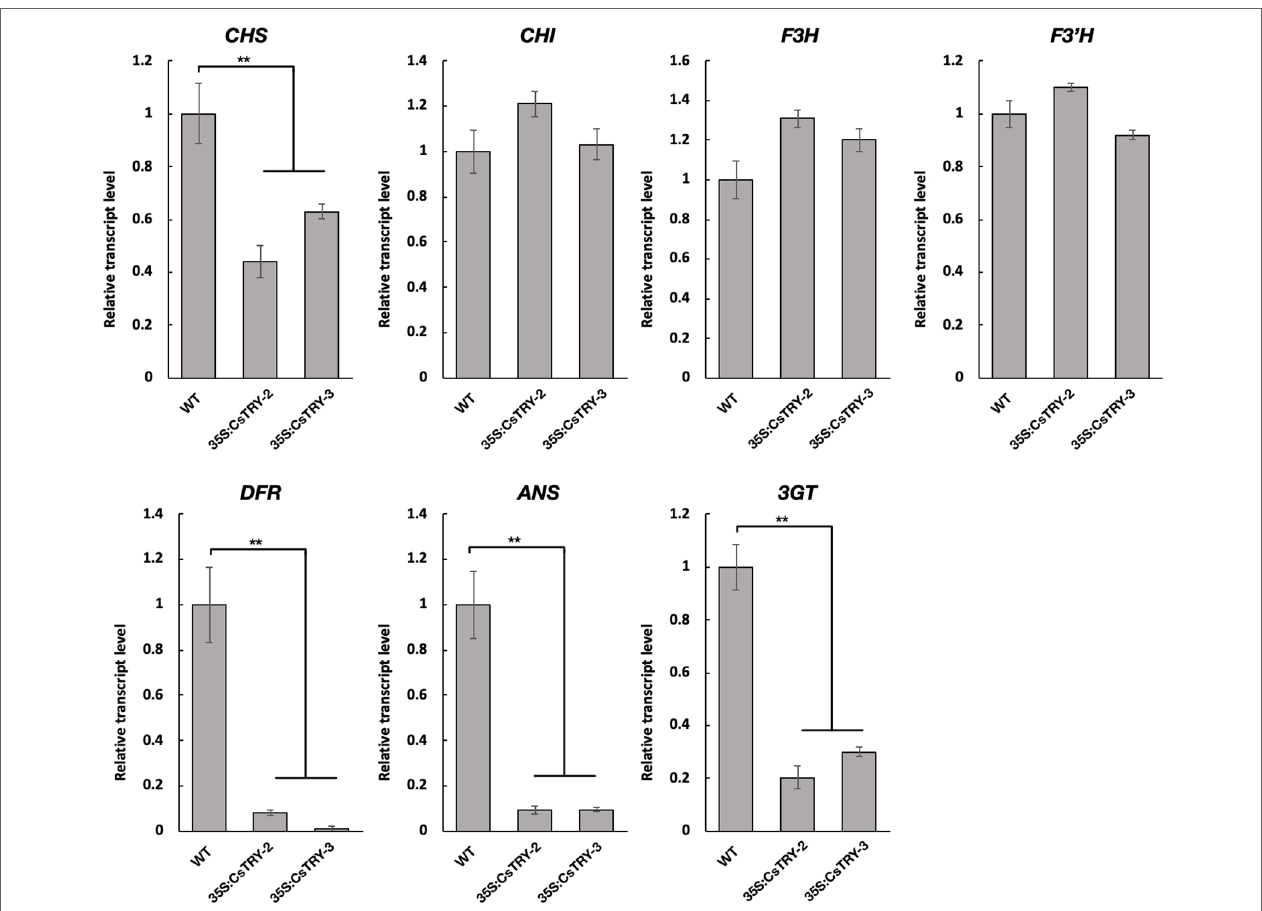
FIgURE 3 | Relative transcript levels of flavonoid structural genes in the petals of tobacco lines 35S:CsTRY (35S:CsTRY-2, 35S:CsTRY-3) and wild type, with the EF1 α gene as an internal control. Error bars represent +SE. Significant differences were determined according to Duncan’s multiple range test (P < 0.05) or Student’s t-test (**P < 0.01).